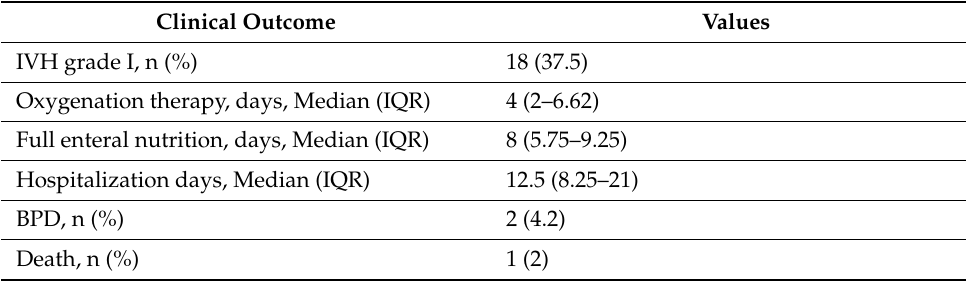
Table 6. Clinical outcomes of the neonates with RDS.